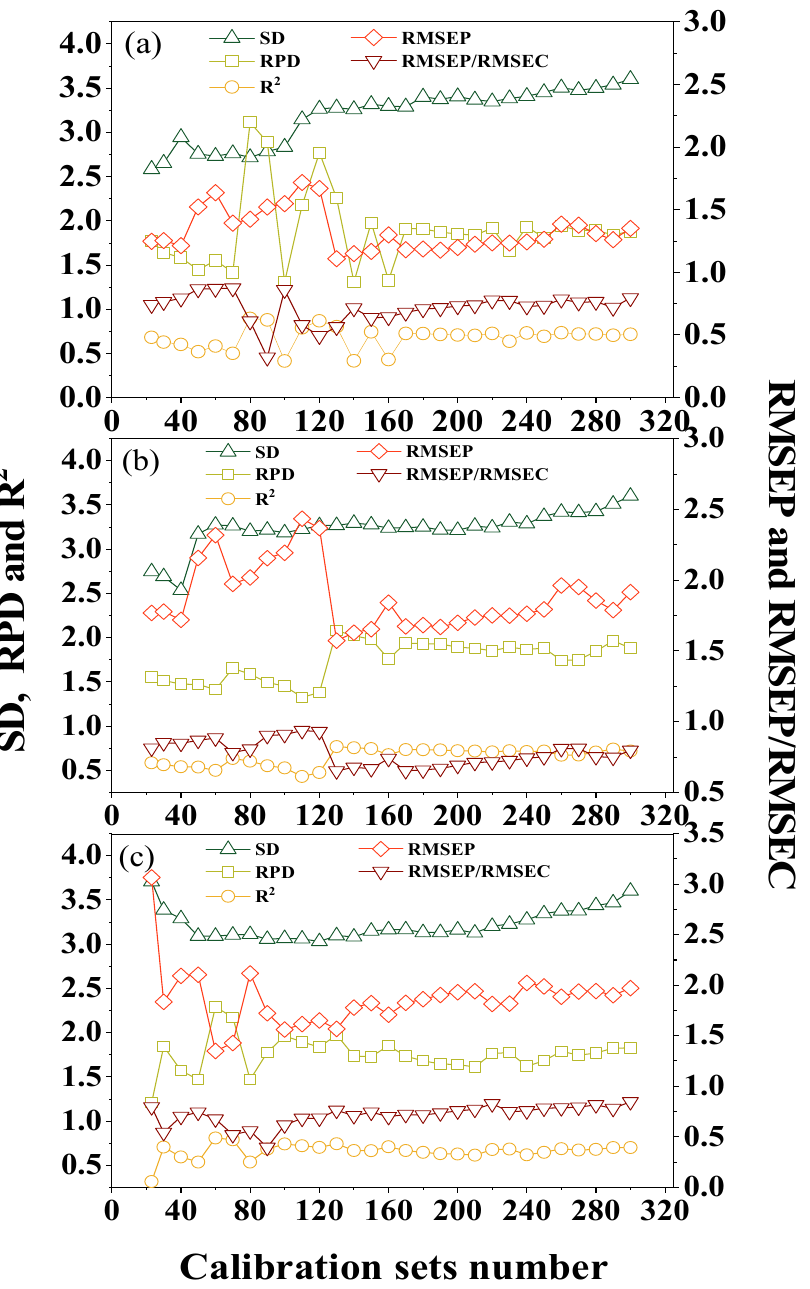
Figure 4. Evaluation of self-adaptive partial least squares regression prediction using the SD, RPD, R 2 , RMSEP and RMSEP/RMSEC of soil samples of various SOM content. ( a ) SOM content: 5.49 g kg − 1 ; ( b ) SOM content: 9.61 g kg − 1 ; ( c ) SOM content: 15.18 g kg − 1